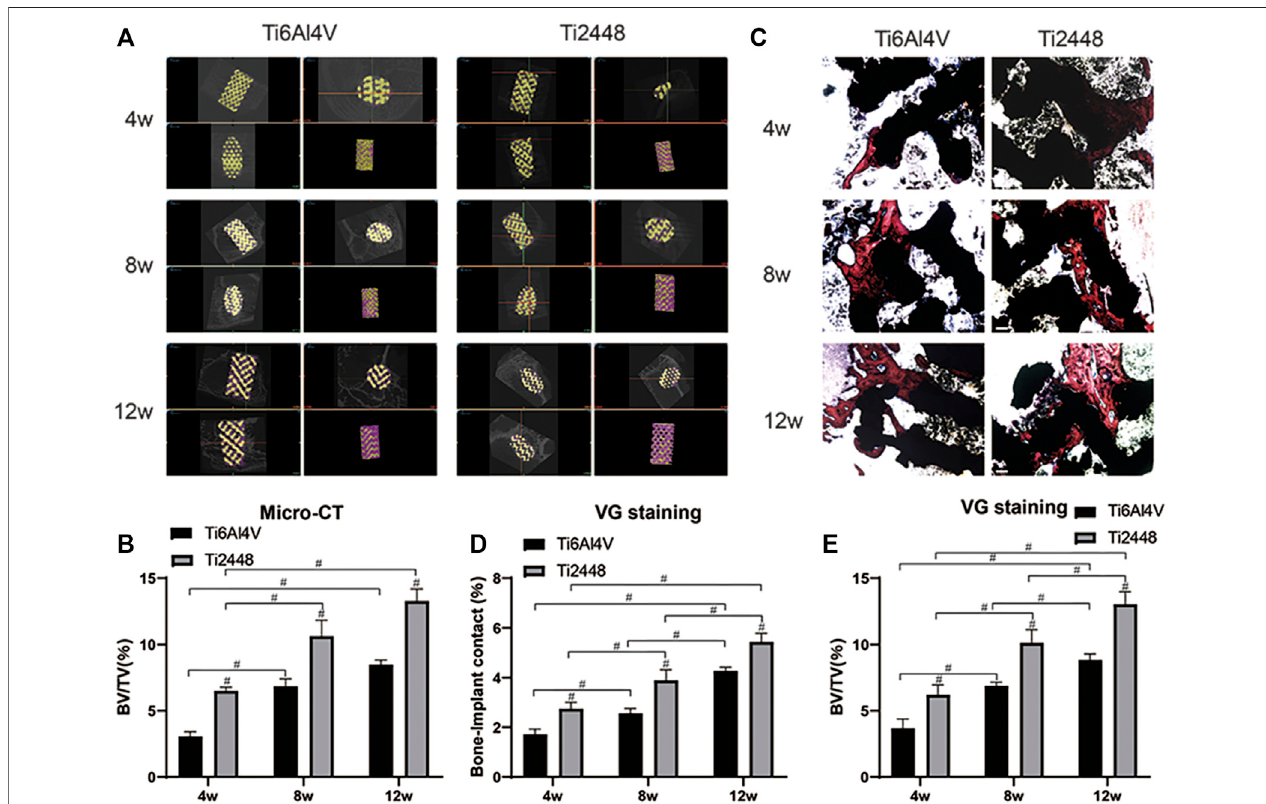
FIGURE 2 | Micro-CT and histomorphometric analysis in vivo . New bone tissue around each scaffold reconstructed by micro-CT (A) . Quantitative analysis of the BV/TV for the different scaffolds at 4, 8 and 12 weeks (B) . Histomorphological analysis of inward growth and integration of bone tissue at corresponding time points. Scale bar (cid:2) 200 µm (C) . Quantitative analysis of the bone − implant contact and BV/TV for different scaffolds at 4, 8 and 12 weeks (D,E) . Note: # p ＜ 0.05 compared to Ti2448.